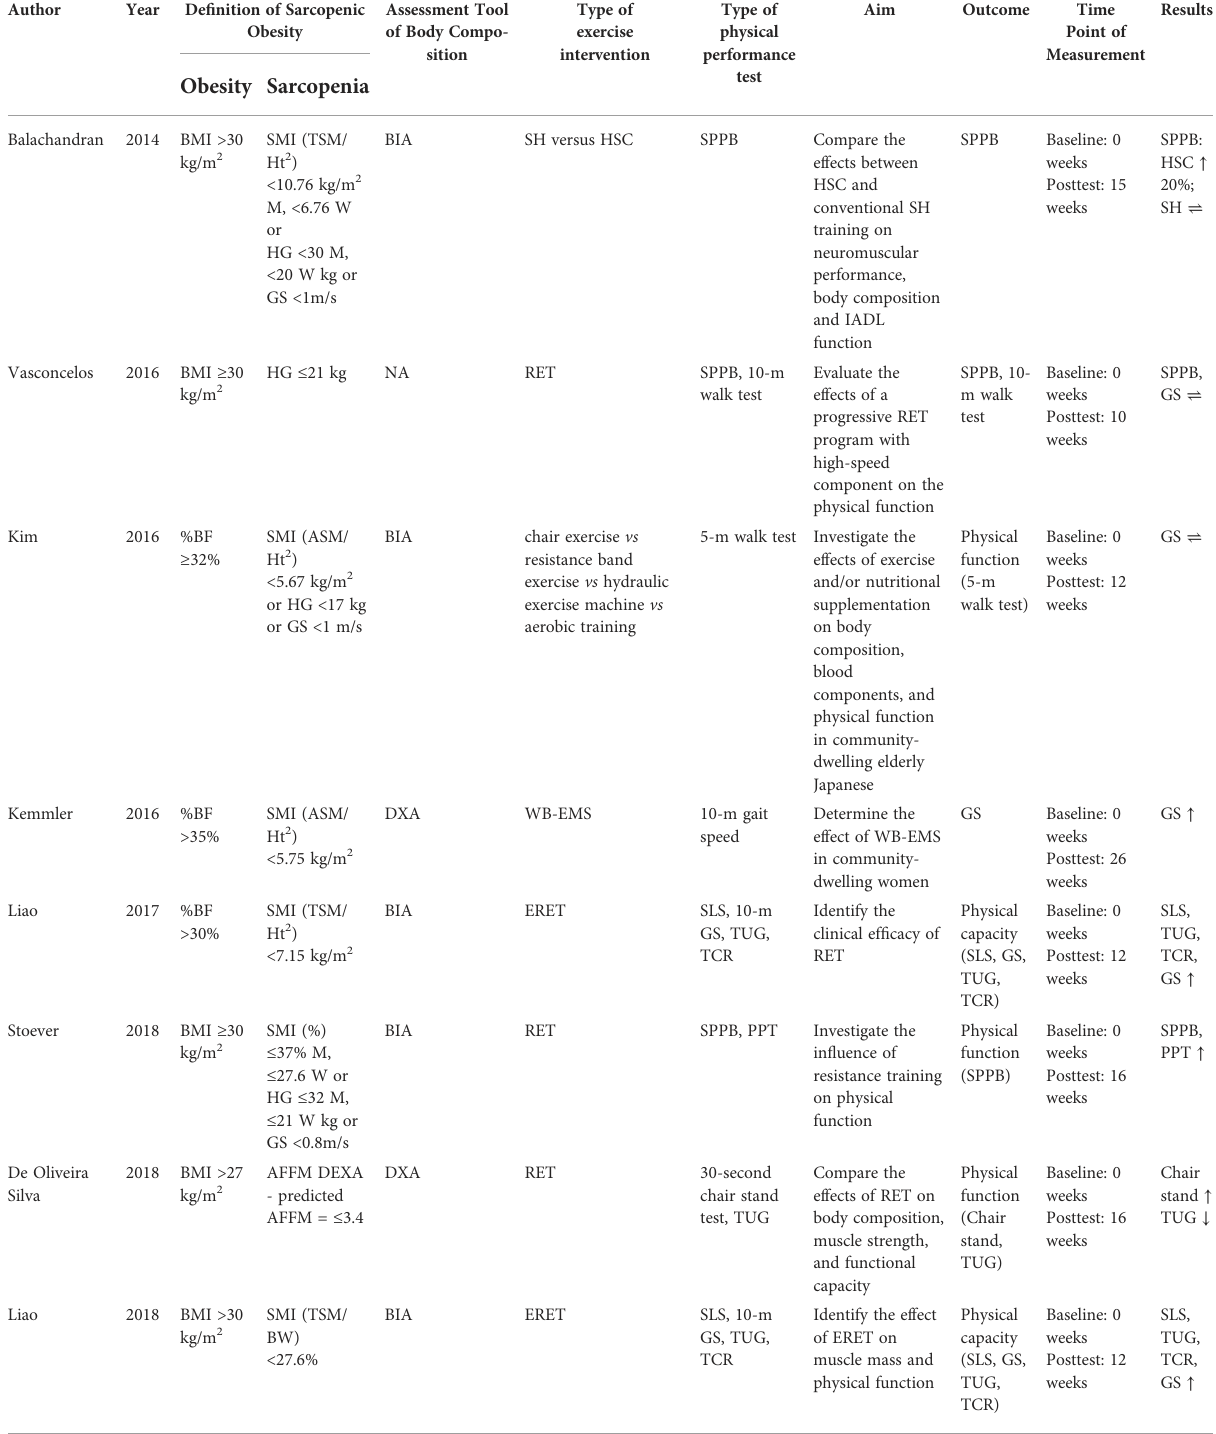
TABLE 2 Characteristics of the